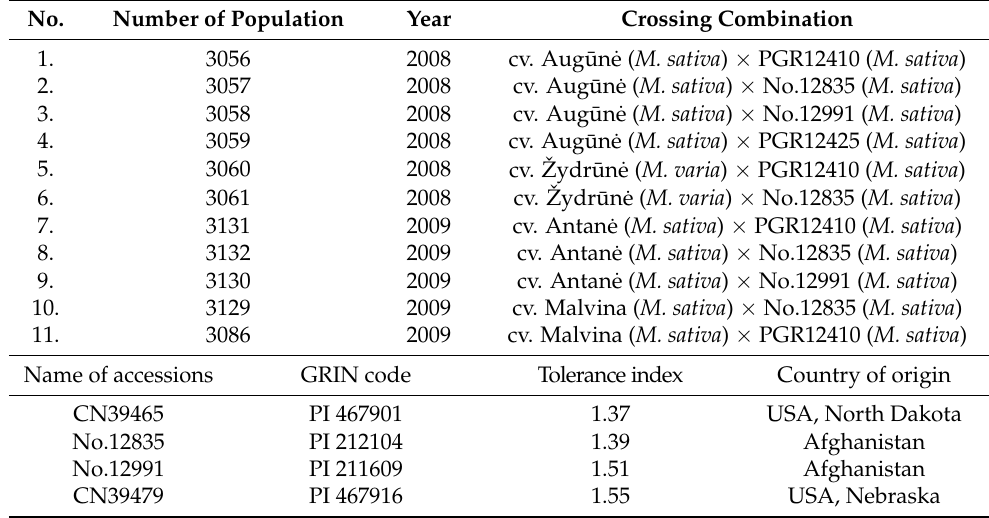
Table 1. The development of alfalfa populations by crossing combinations with the accessions of different tolerance indices to acidic soil.